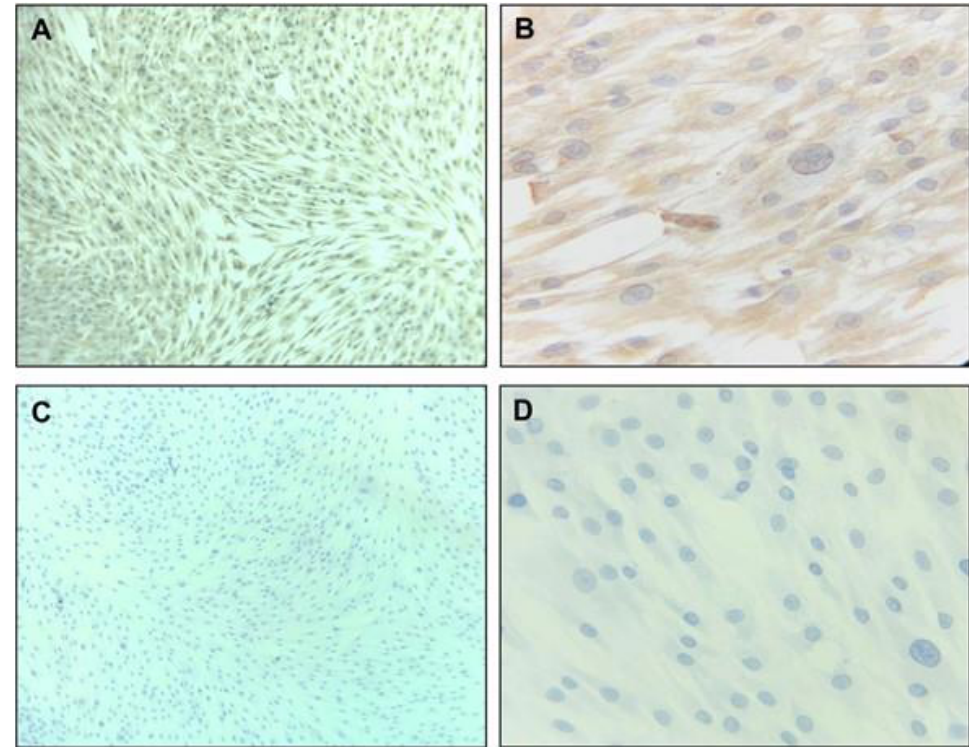
Figure 2. Immunohistochemistry characterization of hDPSC primary culture. hDPSCs (90% conflu- ence, 4 PDL) were cultivated for 48 h. Microphotographs ( A , B ) show strong, positive vimentin, and ( C , D ) show negative for CD34, at 20× and 40×, respectively. hDPSCs = human dental pulp stem cells; PDL = population doubling level.